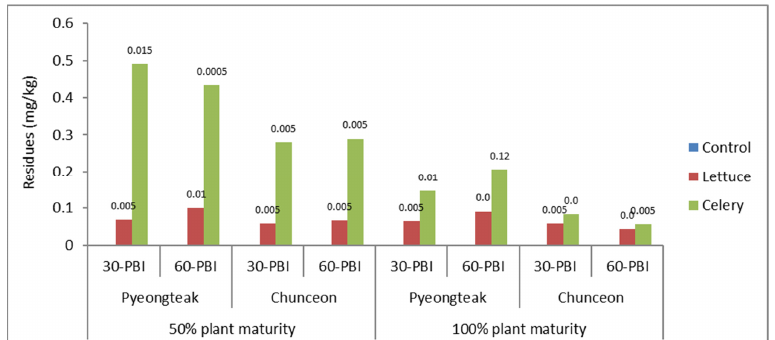
Figure 4. Dinotefuran uptake (mg/kg) by the plants at 50% and 100% plant maturity. Figure legend: values above the columns—standard error; PBI-30—30-day plant back intervals; PBI-60—60-day plant back intervals. Sample size: 4